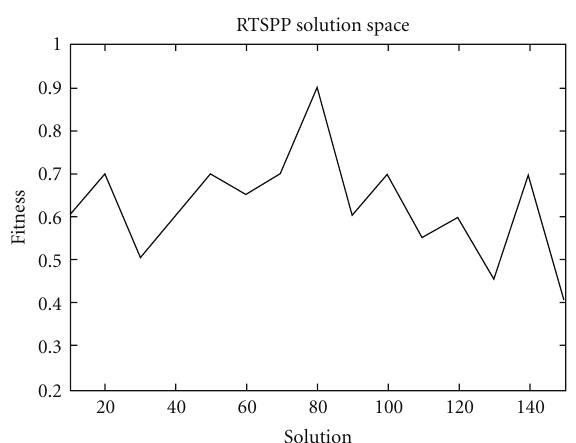
Figure 3: Another hypothetical solution space which has been pruned through the use of a